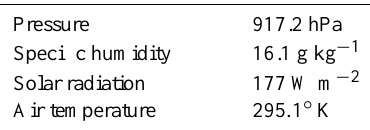
Table 1. Averaged values of surface data at the Kototabang GAW station in June